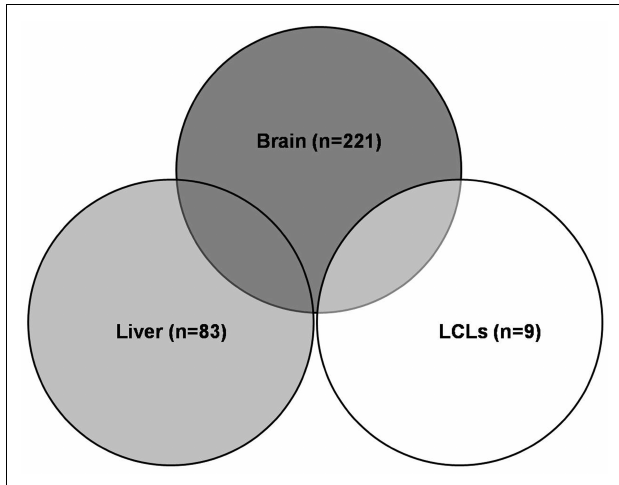
FIGURE 2 | Significant eQTLs in different tissues. A total of 308 significant eQTLs were identified, including 9 eQTLs in LCL, 83 in liver, and 221 in brain tissues. Five eQTLs were shared in two tissue